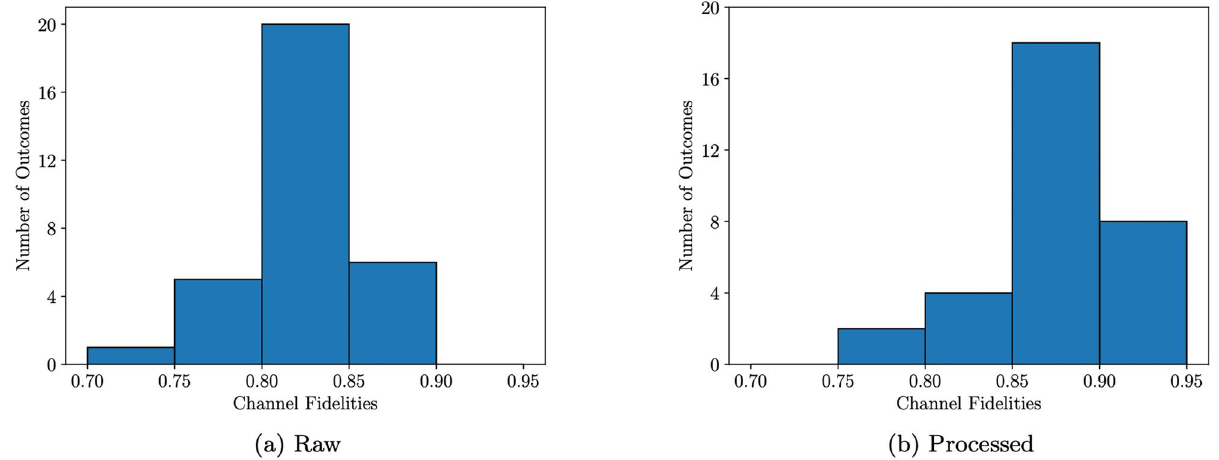
Figure 5. Distribution of channel fidelities for the 32 random unitaries generated with the exact 3-design on the ibmq_toronto quantum processor. ( a ) Raw shows the distribution without quantum readout error mitigation. ( b ) Processed shows the distribution with quantum readout error